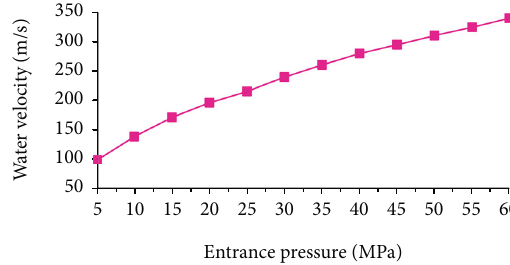
Figure 14: Relationship between the nozzle outlet velocity of the water jet and the nozzle inlet water pressure.